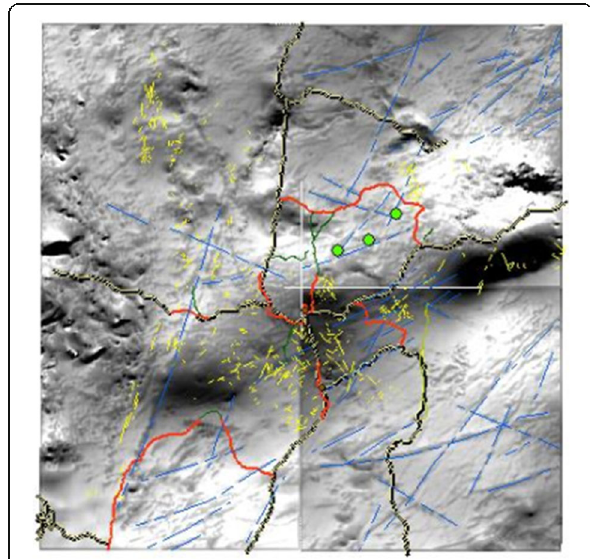
Fig. 9 Shaded relief map of the low amplitude tilt derivative of the area showing the lineaments and location of the epicentres of the